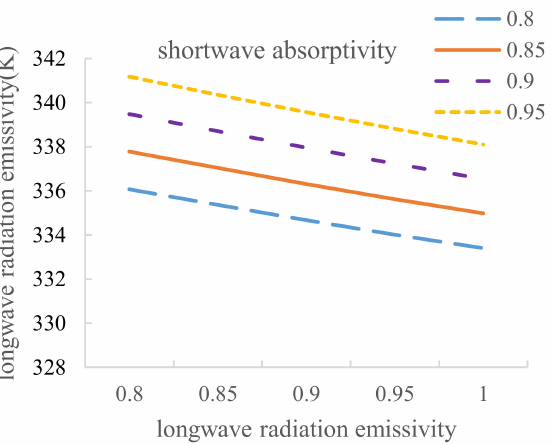
Figure 16. Relationship between pavement equilibrium temperature and longwave radiation emissivity.